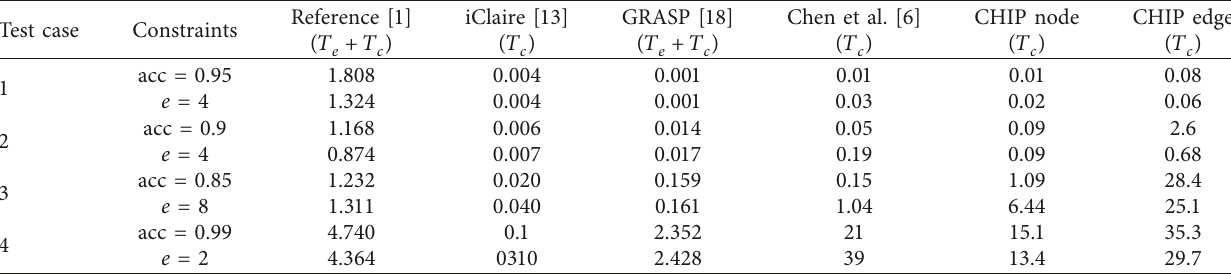
Table 2: Constrained clustering—comparison of CHIP v/s others (runtime (s)).